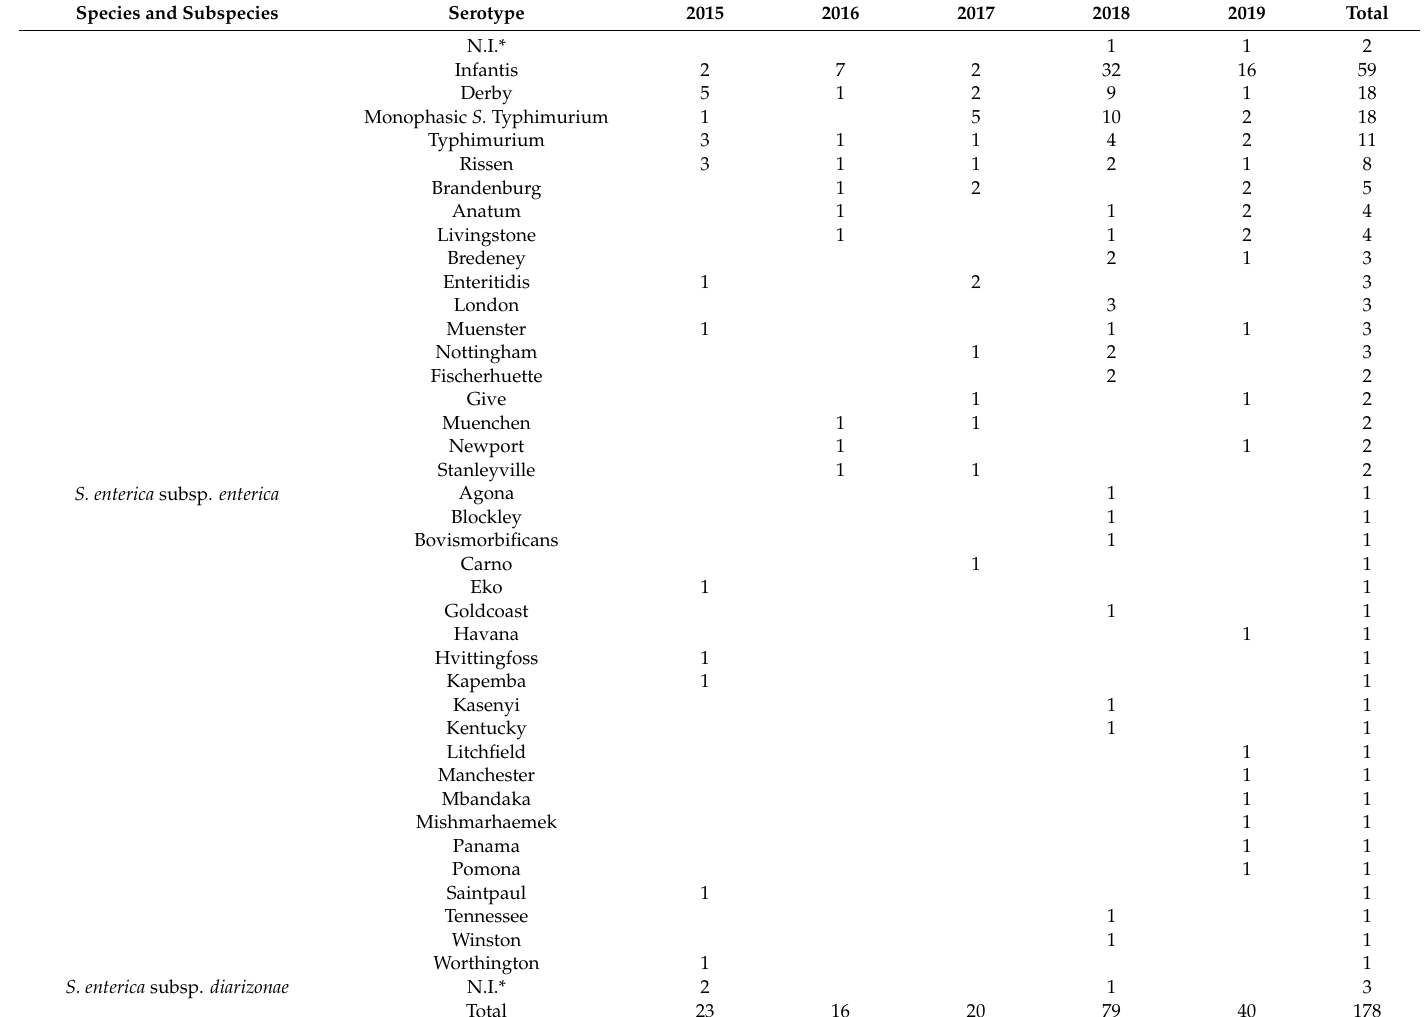
Table 2. Number of serovars isolated from 2015 to 2019 used for the evaluation of the antimicrobial resistance. The asterisk (*) indicates not identified